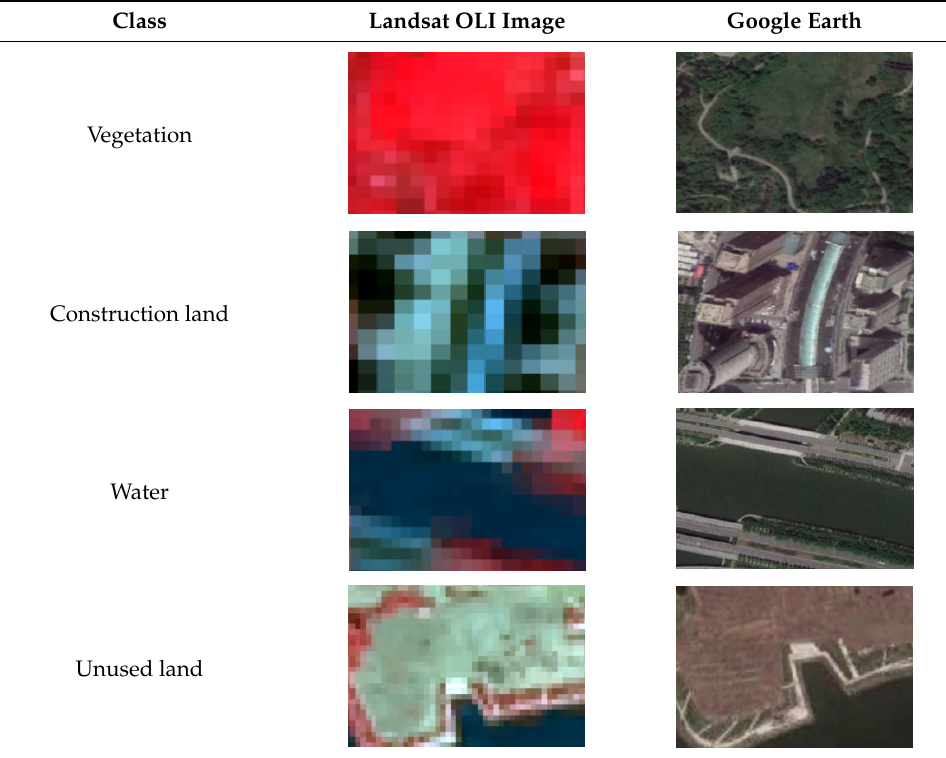
Table 1. Typical image patches of different classes.